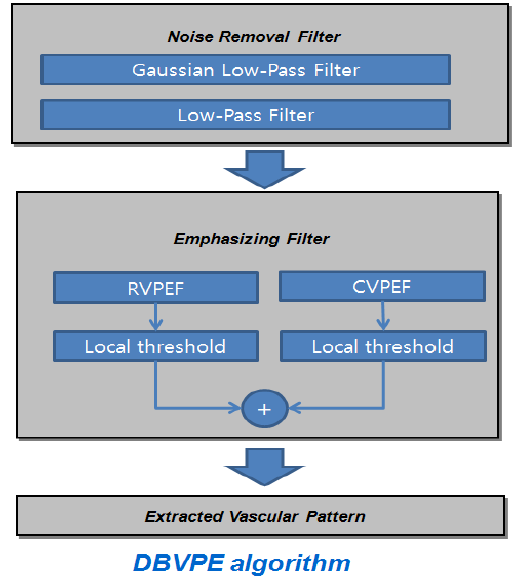
Figure 12. The VPE algorithm processing.